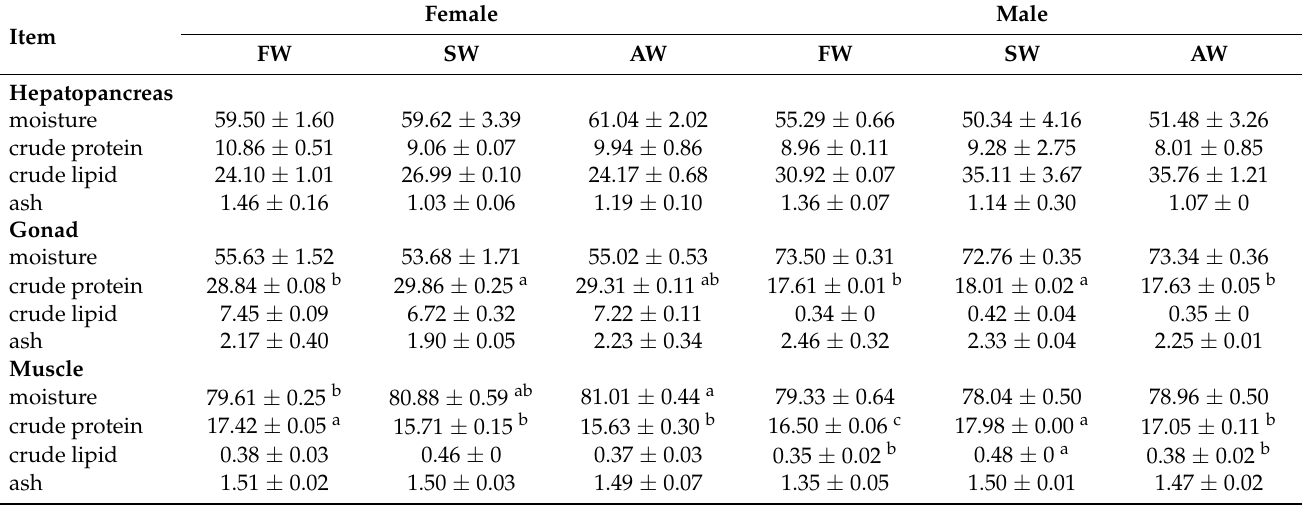
Table 1. The proximate composition (% wet weight) of adult Eriocheir sinensis fattening in different culture